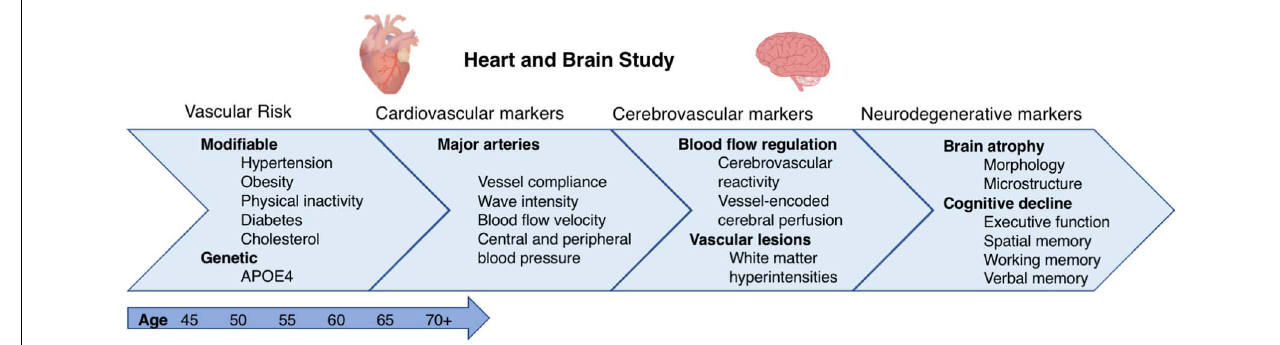
FIGURE 8 | Mechanistic framework for the Heart and Brain Study . The study will examine how 30-year trajectories of vascular risk throughout midlife (40–65 years) affect cardiovascular and large artery phenotypes, cerebrovascular health, longitudinal brain atrophy and cognitive decline at older ages ( > 65 years). The moderating role of genetic risk (APOE4) will also be